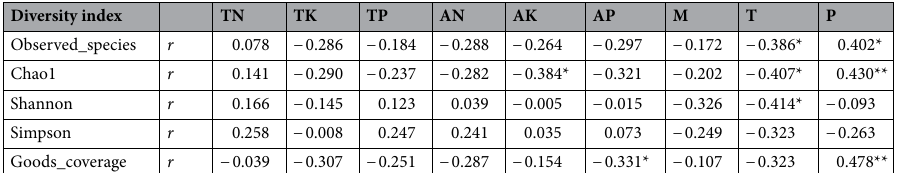
Table 1. Relationship of rhizosphere prokaryotic diversity with the measured environmental variables. The Spearman’s rank correlation coefficient ( r ) are shown. Correlations where p < 0.05 were considered to be significant. TN total nitrogen, TK total potassium, TP total phosphorus, AN available nitrogen, AK available potassium, AP available phosphorus, M moisture, T temperature, P accumulated precipitation 30 days before sampling time. * p < 0.05 and ** p <